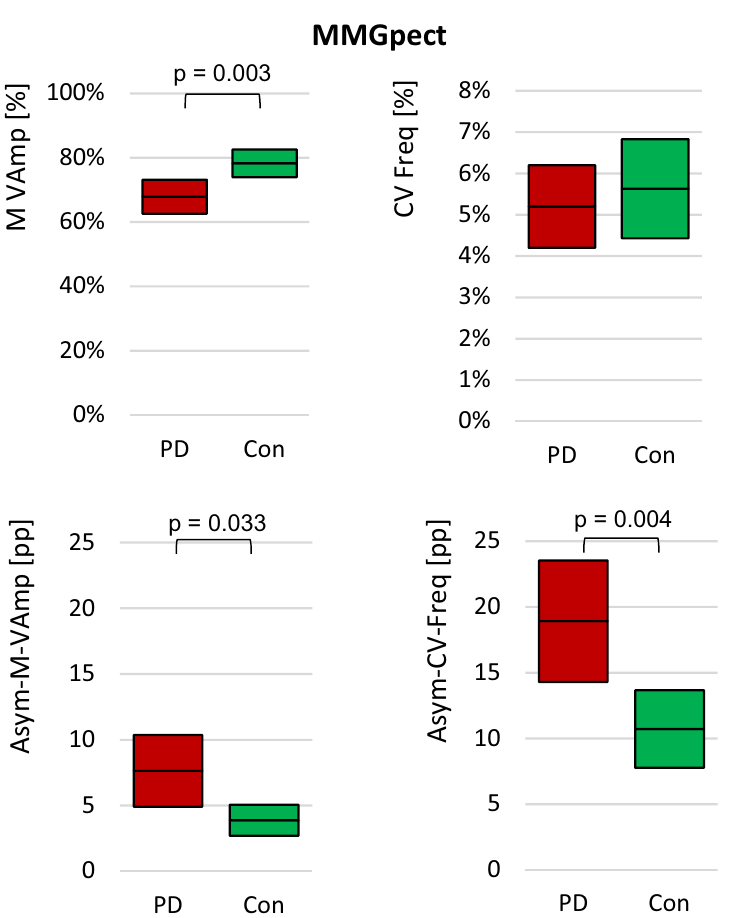
Table 4. Arithmetic means and standard deviations (M ± SD) of the oscillatory parameters (3) to (5) of the ACC and MMG signals including side asymmetries (Asym), significance p and effect size r of PD vs. Con. Significant results are displayed in bold.